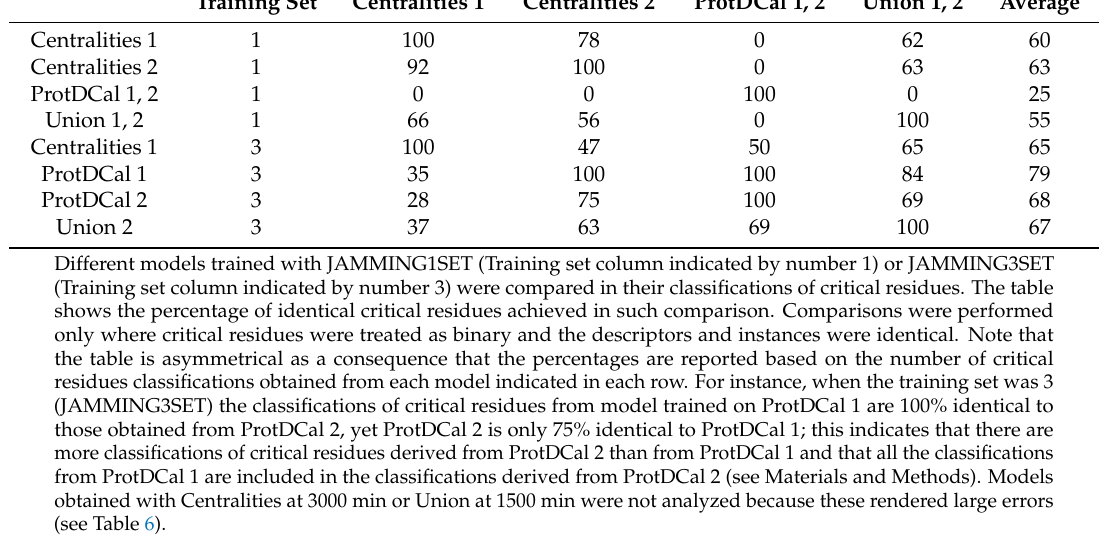
Table 9. Comparison of classifications between critical residues models. Training Set Centralities 1 Centralities